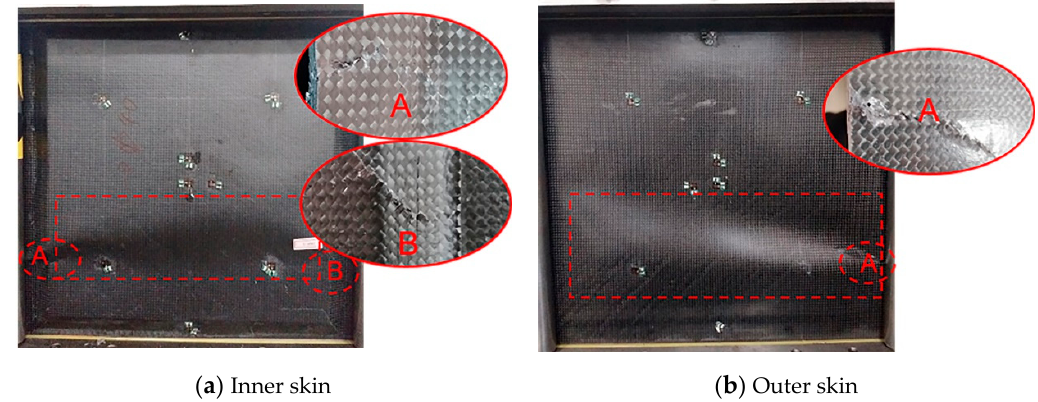
Figure 11. Compressive failure mode of CD40-3. ( a ) Failure mode of inner skin; ( b ) Failure mode of outer skin.